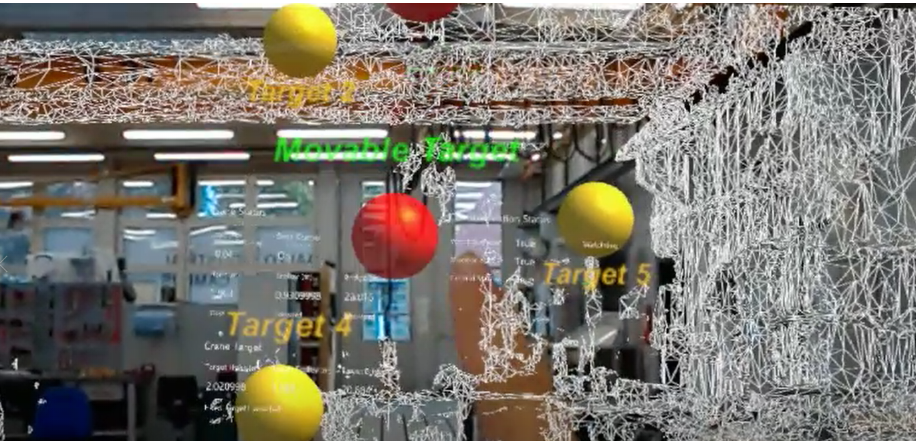
Figure 4. HoloLens view while the user was navigating the movable target: the spatial mapping mesh of the AIIC space captured by the HoloLens camera was also displayed in the scene, to enhance users’ spatial awareness and reduce the risk of placing the movable target in inaccessible